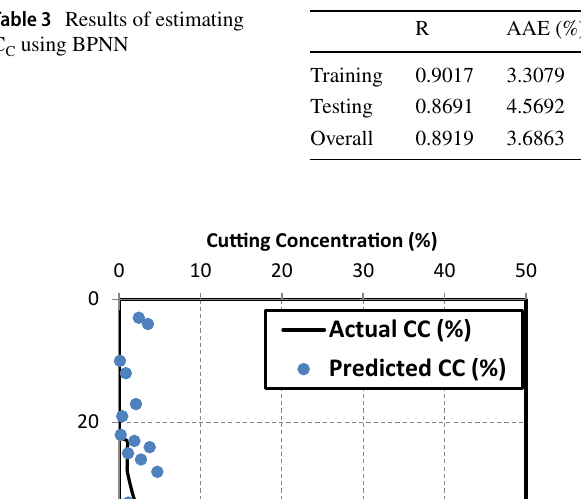
Fig. 8 BPNN-predicted versus actual (experimental) cutting concen- tration from network testing